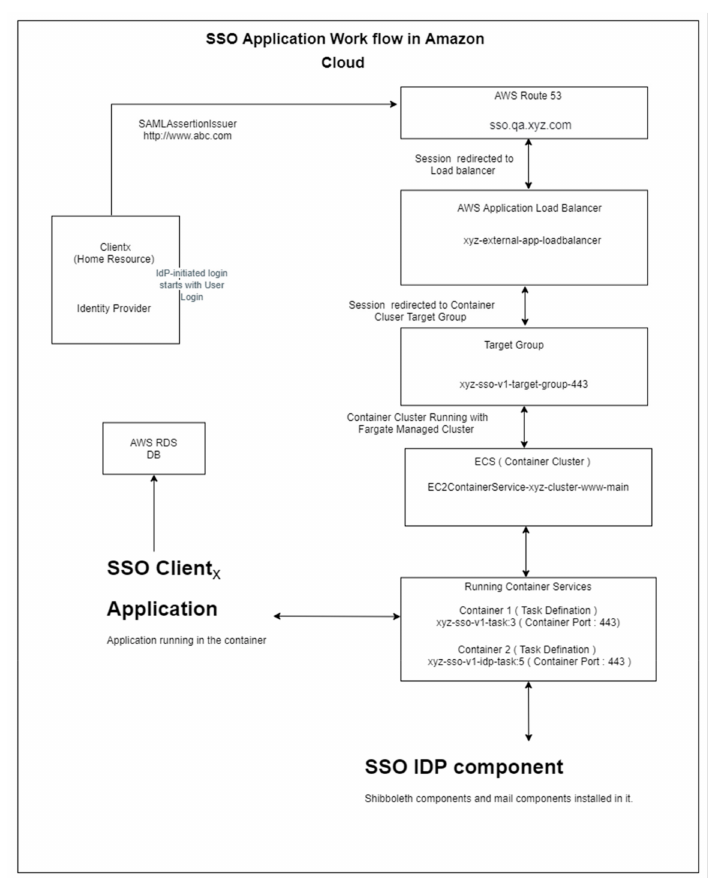
Figure 3. SSO implementation with AWS and